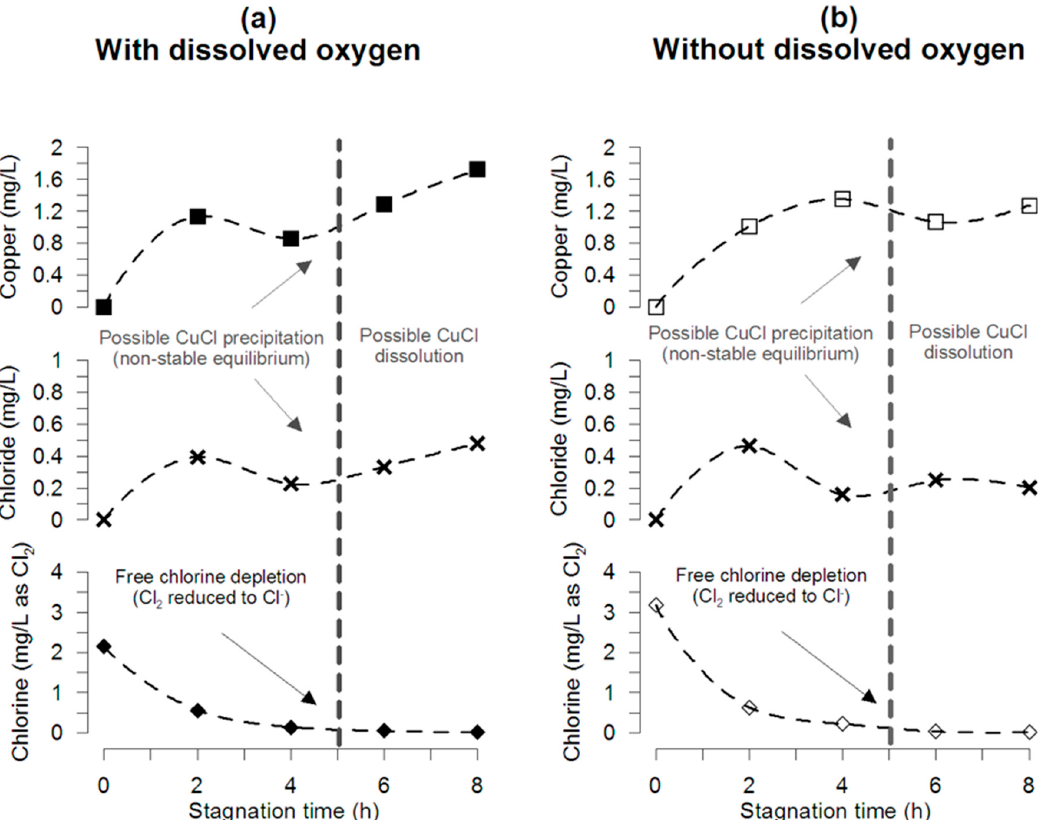
Figure 3. Mass balance during stagnation. A decrease in the copper concentration is reached at 4 h, probably because of Cu-Cl precipitation during the first hour of stagnation. The pipe experiments were conducted using water ( a ) with oxygen (7.59 ± 0.00 mg/L), and ( b ) without oxygen. Interestingly, in both cases, copper and chloride present a minimum concentration at the time that chlorine is almost completely depleted (0.02 ± 0.00 mg/L).